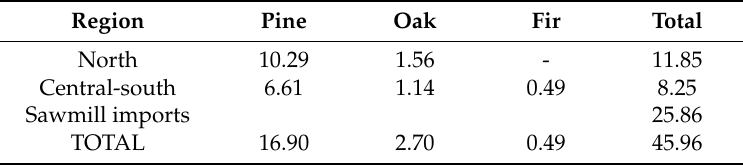
Table 9. Technically available energy from forest woody biomass (PJ) Region Pine Oak